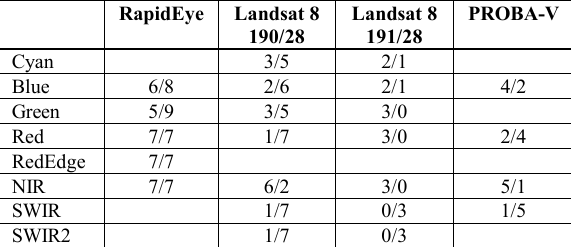
Table 2. Distribution of used irradiance equations (Eq. 1 / Eq. 2) among different sensors and spectral